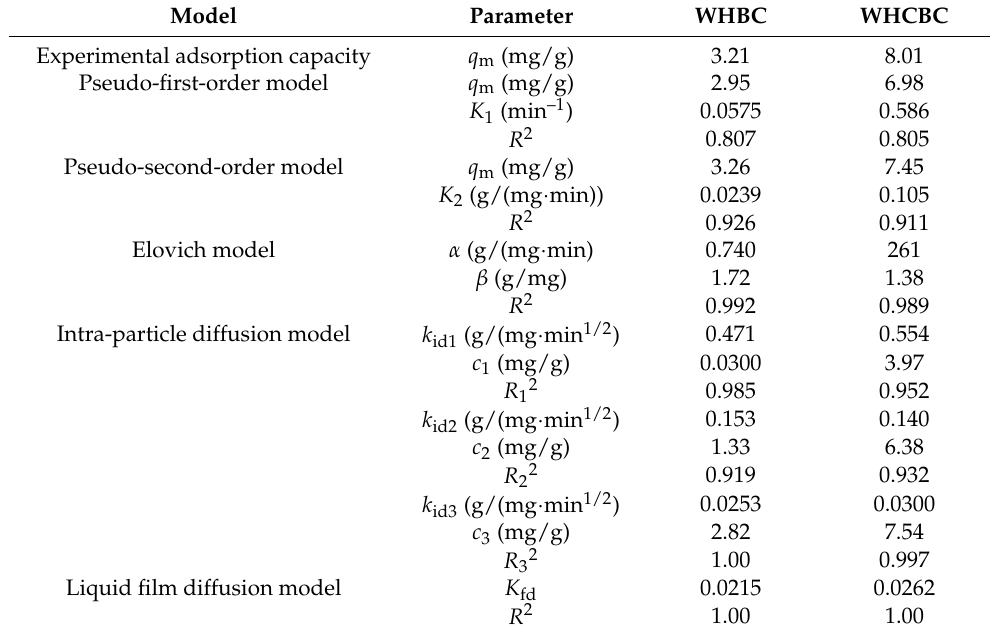
Table 2. Adsorption kinetic parameters for TE on the